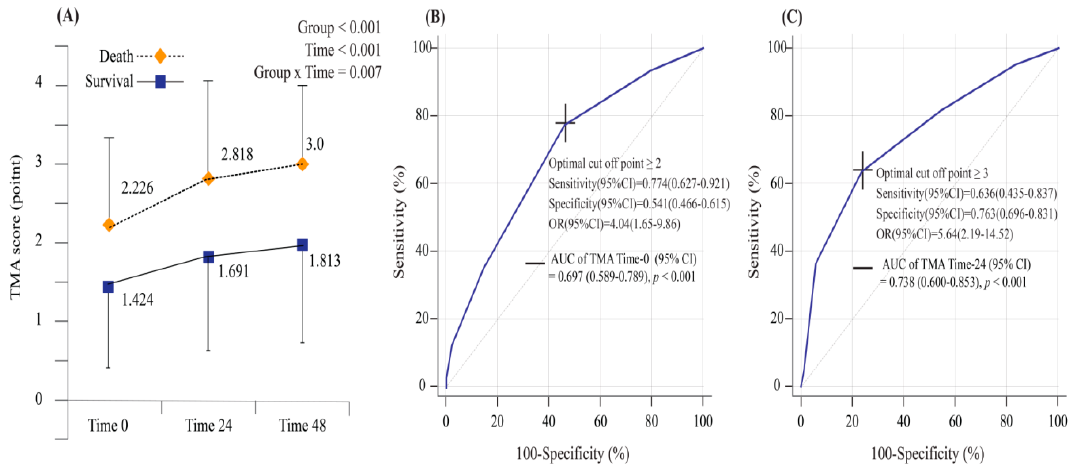
Figure 2. ( A ) Linear mixed model of the thrombotic microangiopathy (TMA) score to estimate significant di ff erences between groups over time according to 30-day mortality. The receiver-operating characteristic curves for predictability of the TMA score at admission ( B ) and 24 h ( C ) after admission according to 30-day mortality are shown.